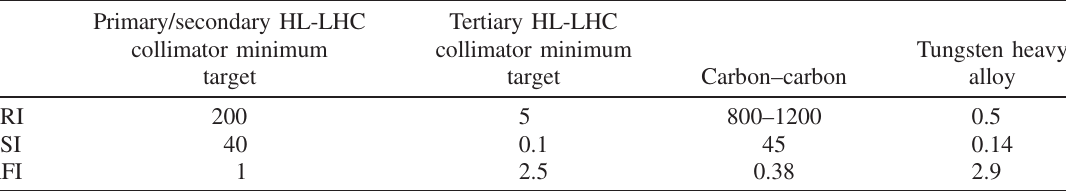
TABLE I. Figures of merit for CFC and tungsten alloy currently adopted in LHC collimators, and the requirements for